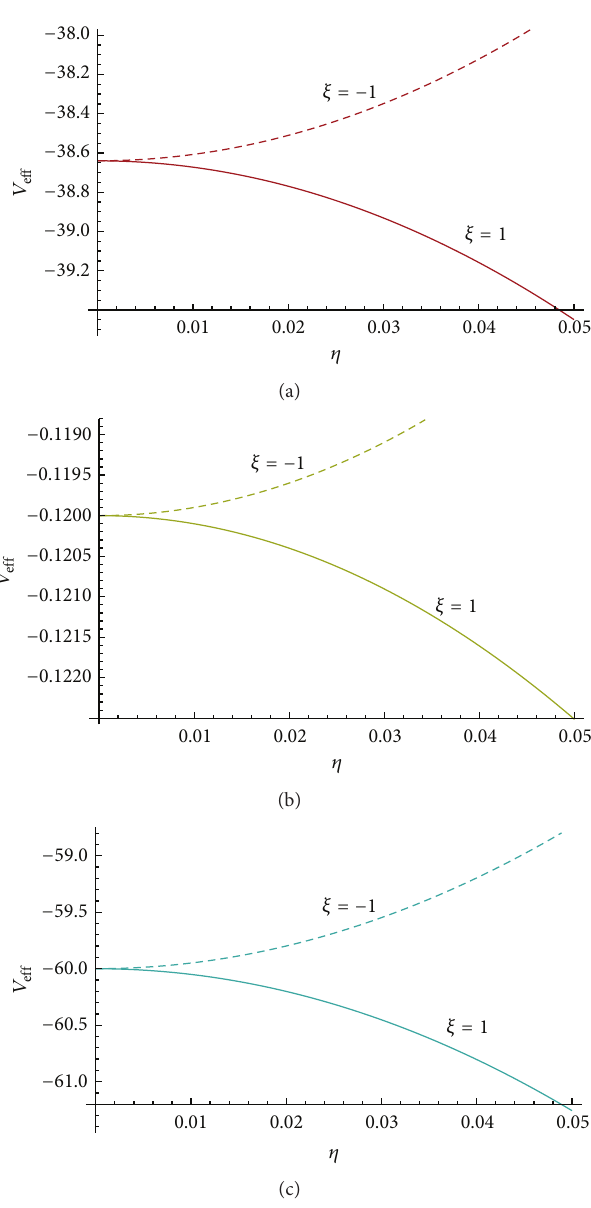
) for ordinary and eff